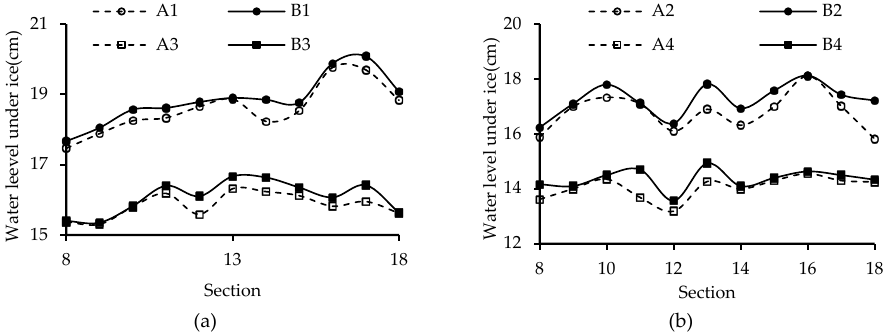
Figure 8. Comparison of water depth under an equilibrium ice jam with a local scour around the pier to those without a local scour. (( a ): H 0 = 0.25 m, V 0 = 0.17 m/s and H 0 = 0.20 m, V 0 = 0.17 m/s; ( b ): H 0 = 0.25 m, V 0 = 0.15 m/s and H 0 = 0.20 m, V 0 = 0.15 m/s).